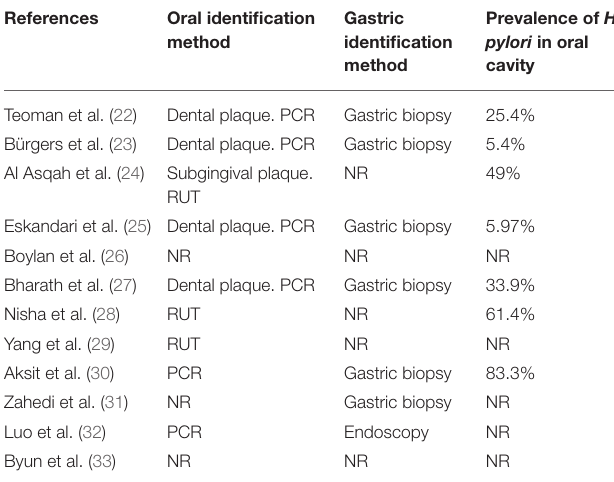
TABLE 2 | Helicobacter pylori identification method and prevalence in oral cavity/plaque.